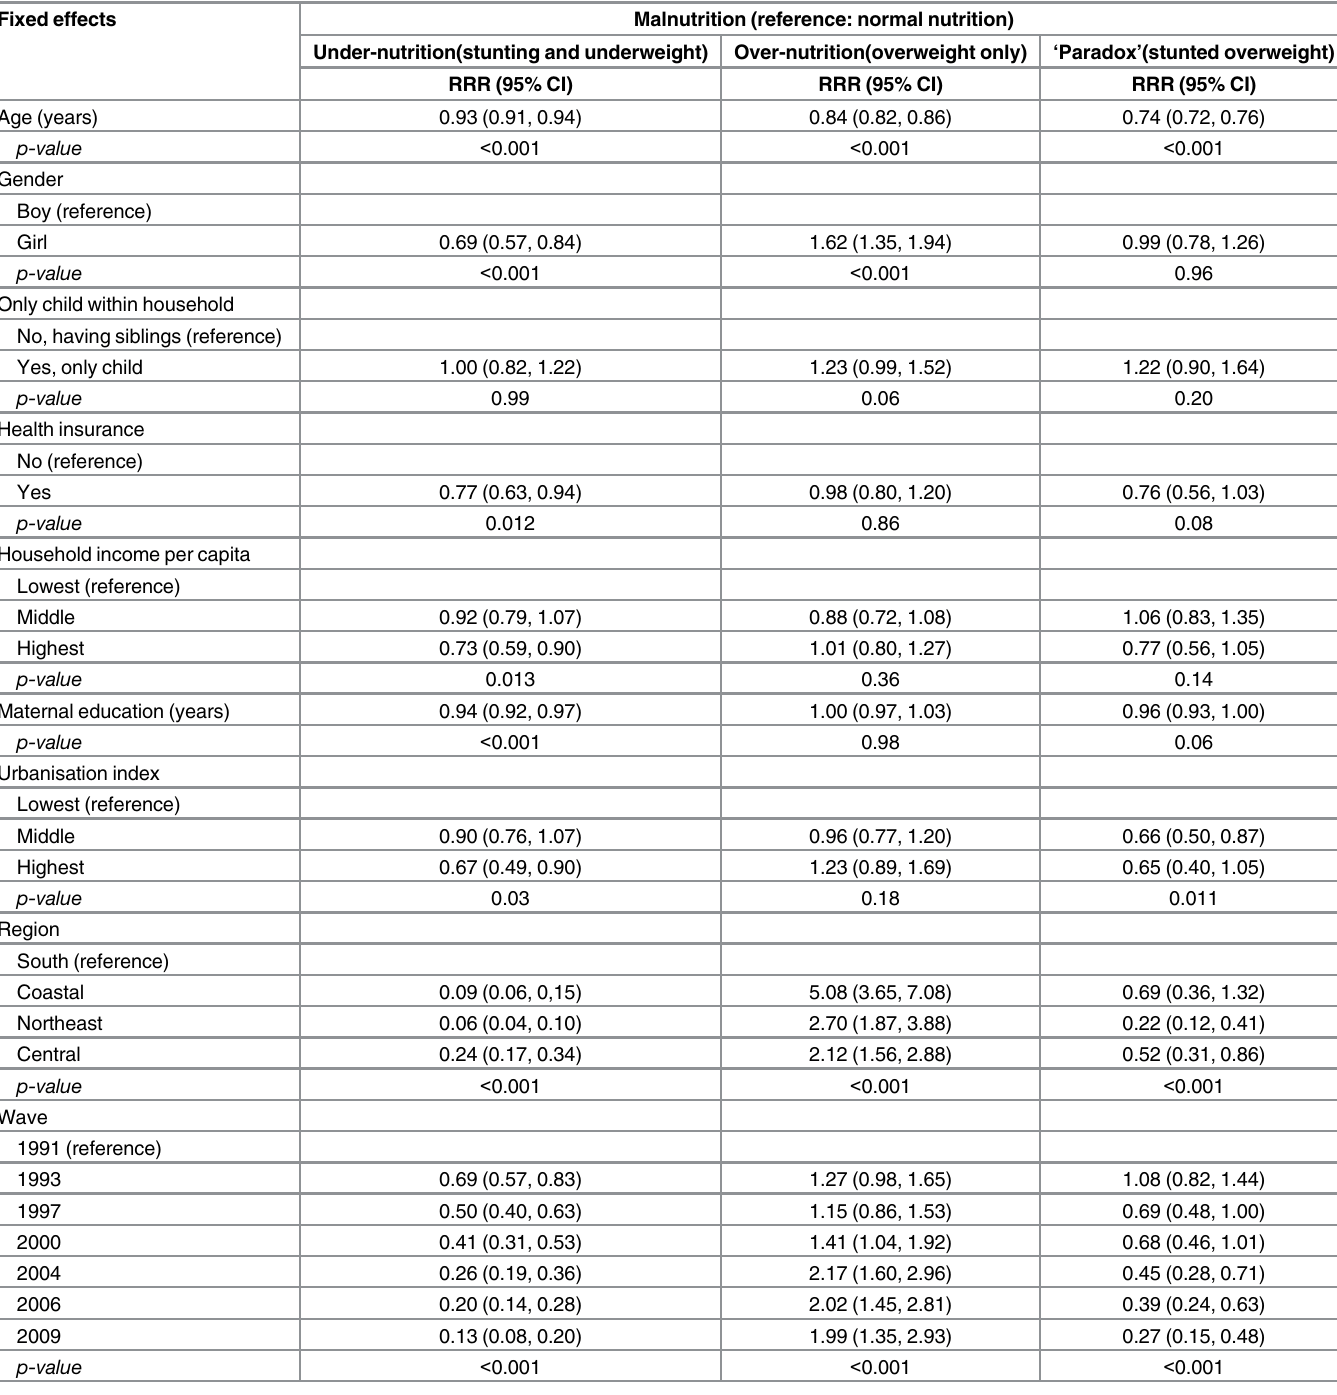
Table 4. Adjusted relative risk ratios (RRR) and 95% confidence intervals (CI) for predictors of unordered multinomial logistic models [using nor- mal nutrition without being stunted, underweight or overweight as the reference] predicting malnutrition for children less than 18 years from the CHNS, 1991 –